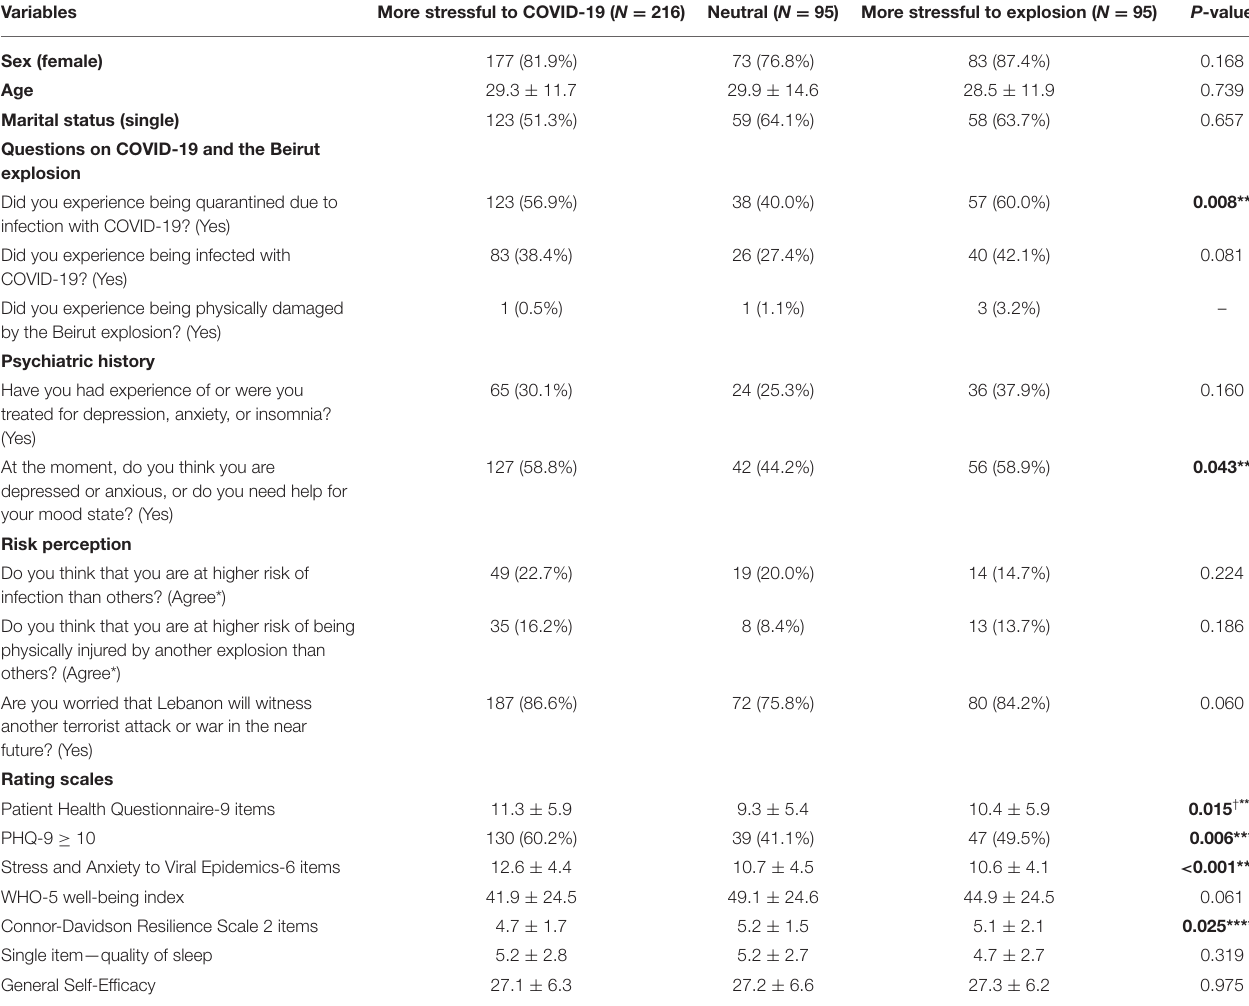
TABLE 3 | Comparison of demographic variables and rating scales scores among subjects grouped based on the responses to the question of “now, is COVID-19 more stressful than an explosion to you?” ( N = 406).